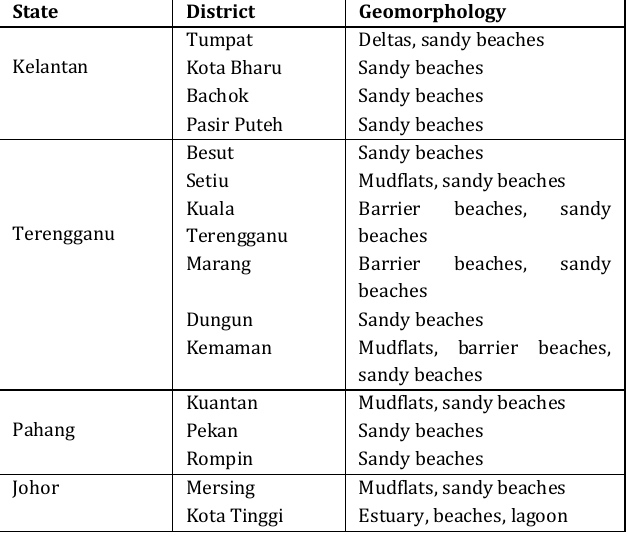
Table 1: Geomorphology of each district along the East Coast of Peninsular Malaysia [19].